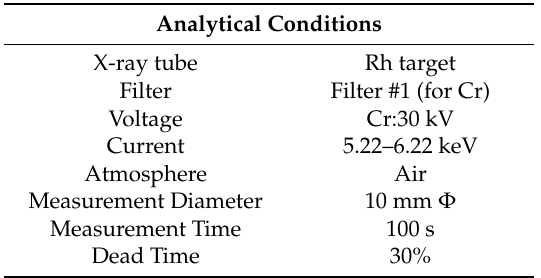
Table 4. Energy dispersive X-ray (EDX) analytical conditions.